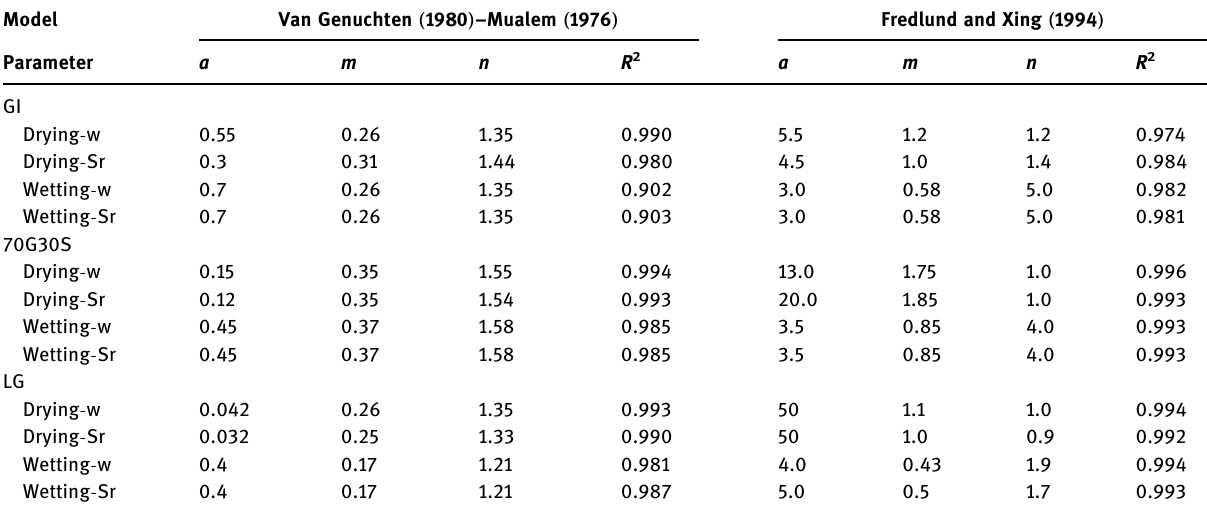
Table 2: Fitting parameters for drying and wetting paths of SWCCs of GI, 70G30S, and LG soils